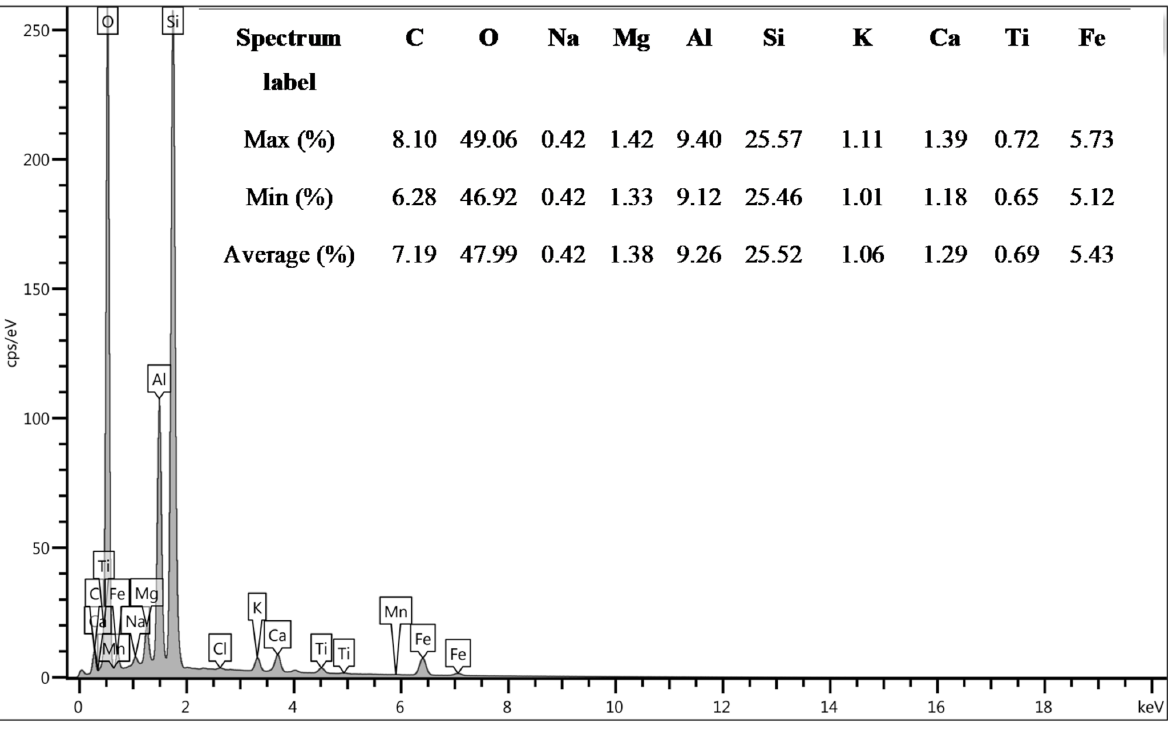
Figure 4. EDS spectrum of the unstabilised